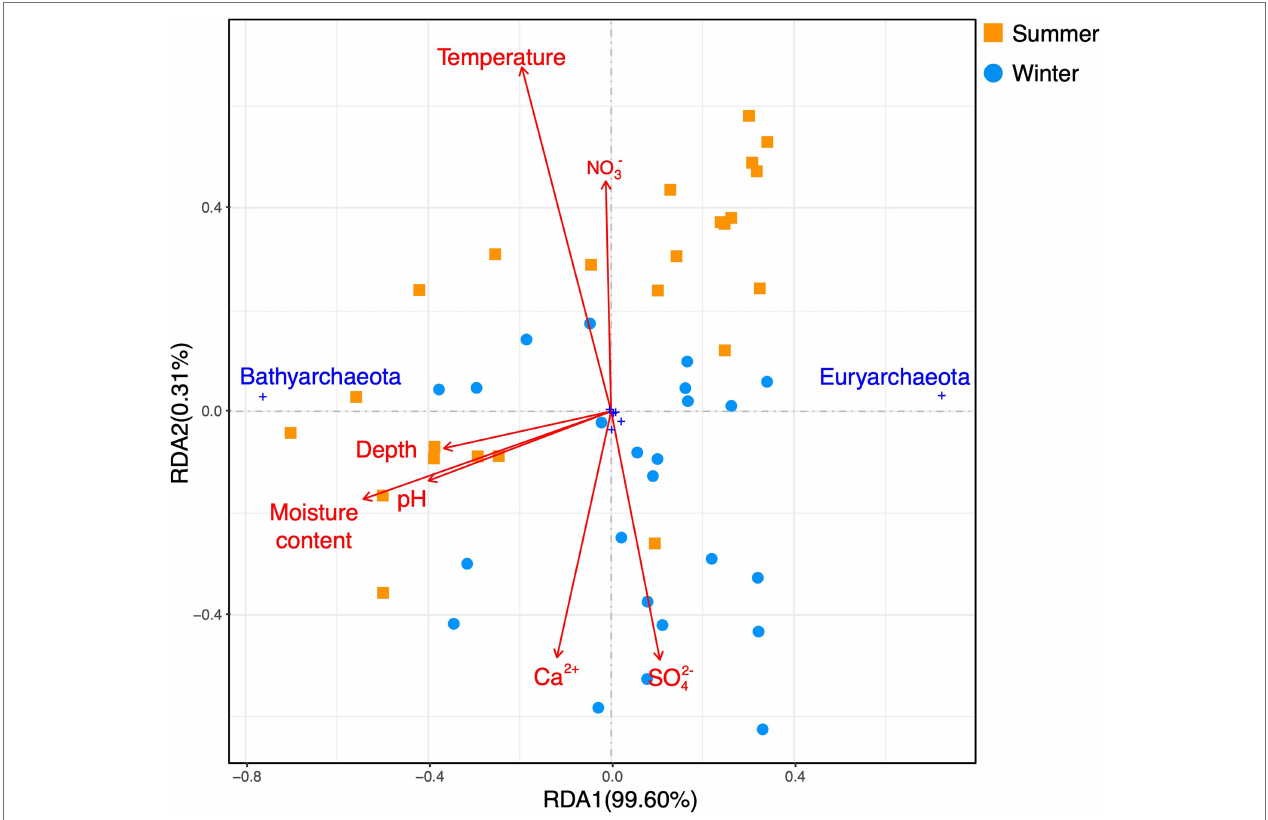
FIGURE 6 | A redundancy analysis based on environmental variables (pH, depth, moisture content, surface sediment temperature, and dissolved Ca 2+ , sulfate, and nitrate in the sediment pore water) fitted to the proportions of archaeal